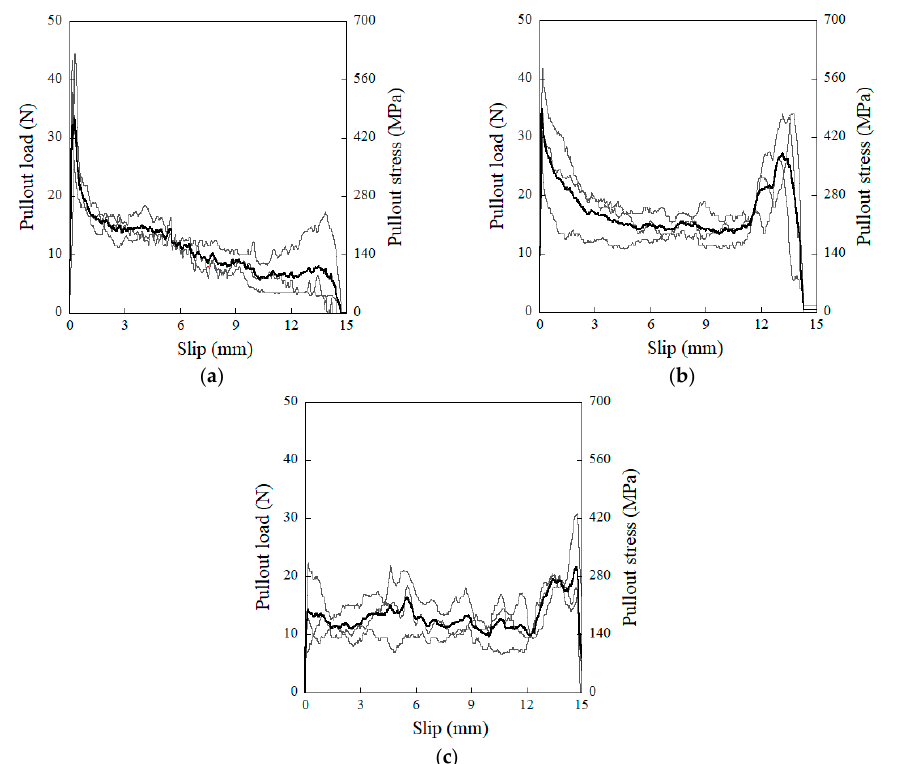
Figure 9. Pullout load (stress) versus slip response of steel fibers embedded in a mortar mixture containing MGFs: ( a ) M0.00, ( b ) M0.05, and ( c ) M0.10. Table 6. Pullout parameters of steel fibers embedded in a mortar mixture containing